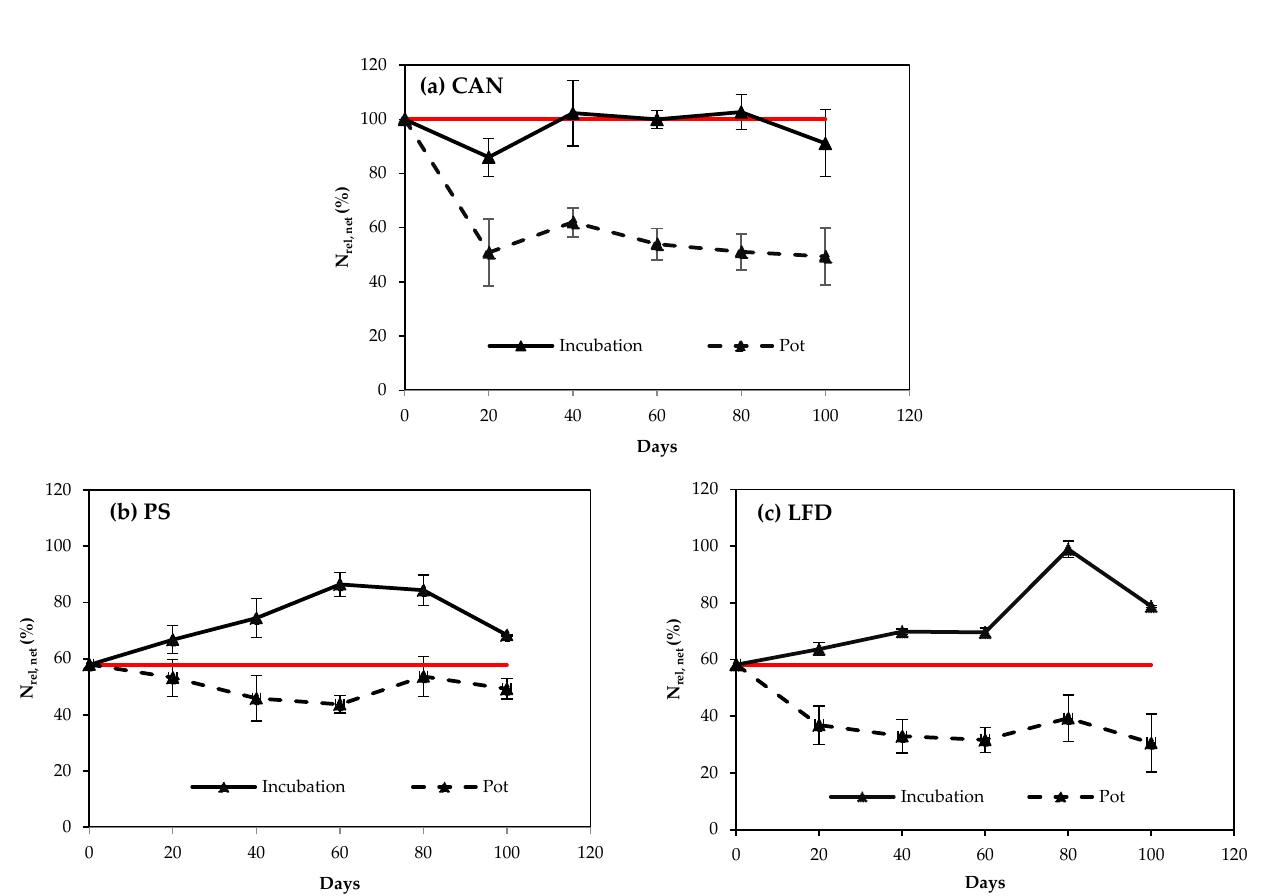
Figure 3. Dynamics of plant-available N (mg kg −1 dry weight (DW), mean ± standard deviation; n = 4) in the soil of incu- bation ( a , c , e , g ) and maize-growing pot ( b , d , f , h ) in 100 days. No N fertilizer-control ( a , b ), calcium ammonium nitrate — CAN ( c , d ), pig slurry — PS ( e , f ), and liquid fraction of digestate — LFD ( g , h ). Data at t = 0 were estimations according to measurements in the control and the fertilizer application rate. In maize-growing pots, total plant-available N was calcu- lated as the sum of mineral N in the soil and N uptake in the roots and shoots.